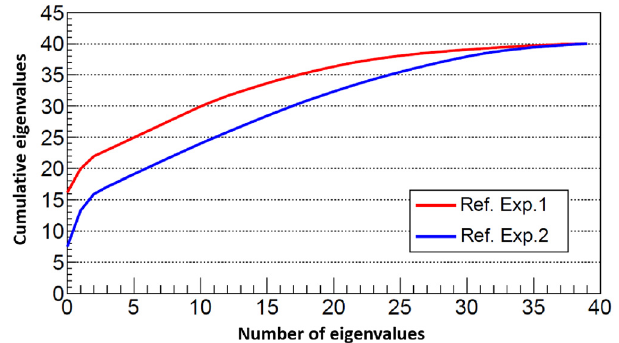
Fig. 10. The cumulative eigenvalues of the correlation matrix of the N ð A Þ for the Exp.1 in blue and the Exp.2 in red.